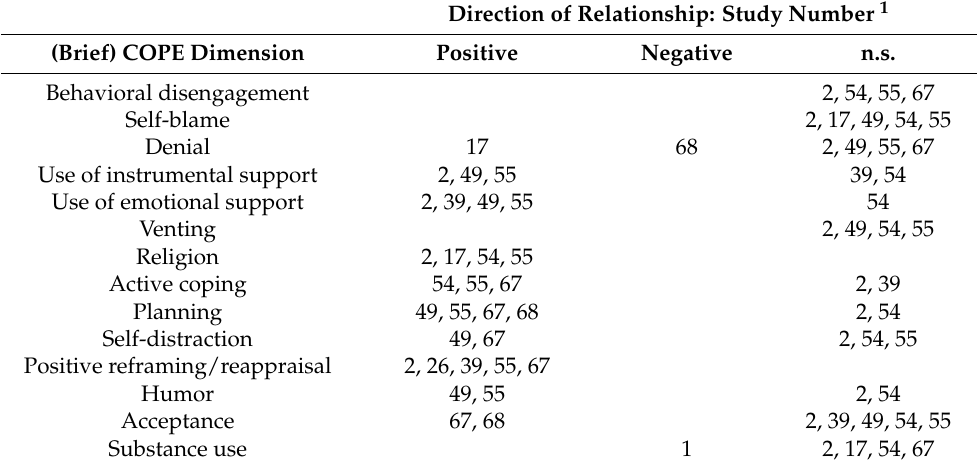
Table 5. Relationships of single (Brief) COPE dimensions with the PTGI total score. Direction of Relationship: Study Number